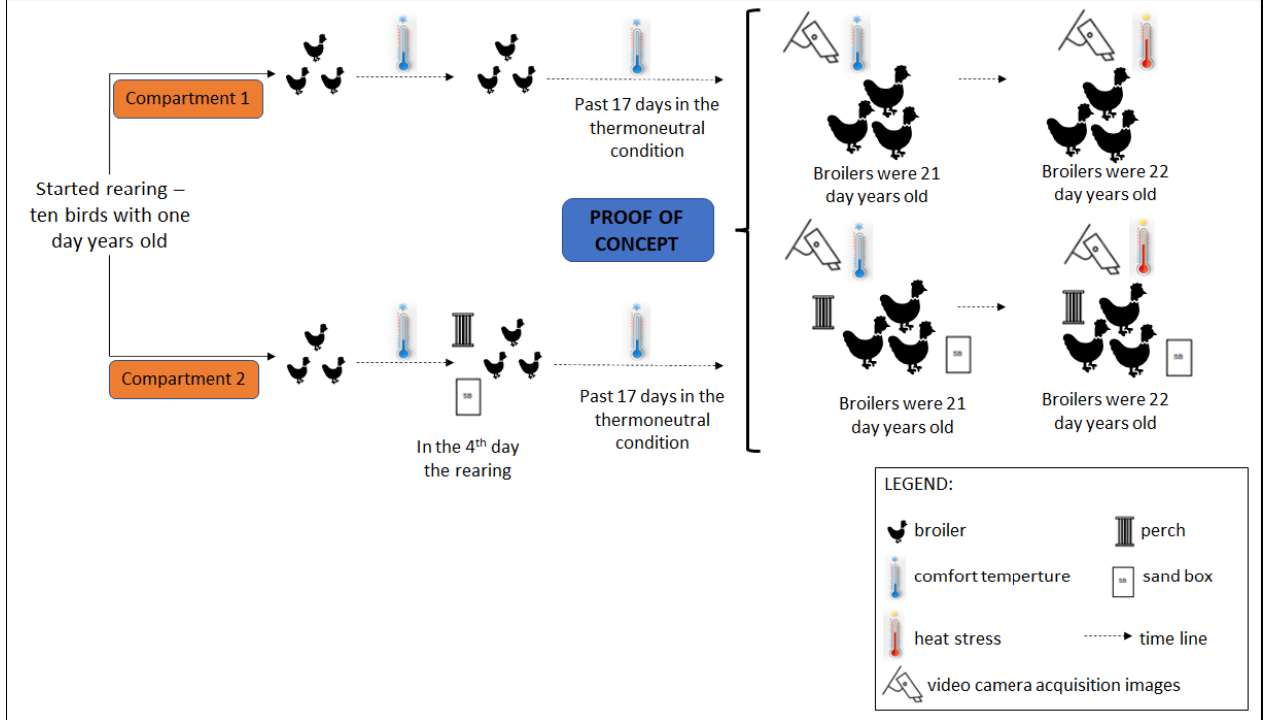
Figure 4. Diagram of the methodology used for proof-of-concept tests.